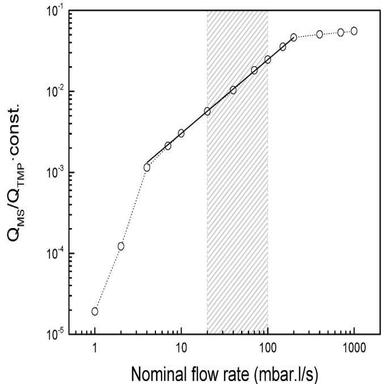
Ratio of the MS and TMP gas flow fractions (within a constant) as a function of the nominal mass flow rate. The shaded area shows the applicable range for the studied lunar regolith simulant materials. A power law fit (solid line) yields an exponent of β = 0.92 ± 0.01.